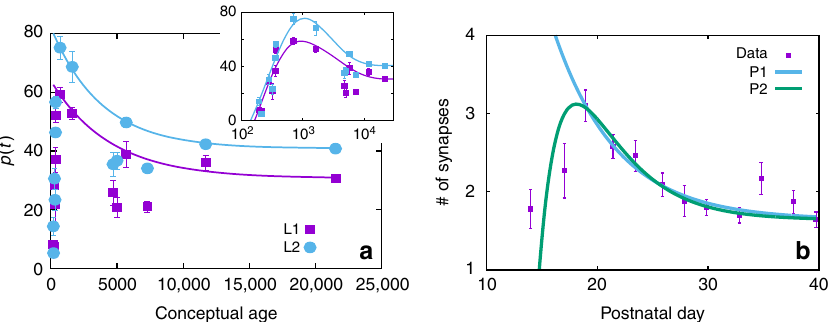
Fig. 2 Synaptic pruning. Experimental data sets on connectivity during infancy (points) and model fi t (solid lines). a Data points correspond to synaptic density, ρ ( t ) ∝ κ ( t ), in the human infant brain, obtained in autopsies by directly counting synapses in tissues from different layers of the auditory cortex (here shown layers 1 (L1) and 2 (L2)) 32 . The solid lines present the best fi t obtained by the model, with τ p , L 1 = 1600(300) and τ p , L 2 = 3800(100). Other parameters are extracted from the data: L1: κ 0 = 59.1, κ ∞ = 30.7 and t 0 = 700; and L2: κ 0 = 75.1, κ ∞ = 40.8 and t 0 = 700, where t 0 is set at the onset of pruning (i.e., corresponding to the maximum of κ ( t )). Inset on the right shows the fi t of the maximum on a log – log scale, labels as in the main plot. Parameters from the fi t are a L 1 = 33(5), τ g , L 1 = 210(20), τ p , L 1 = 3800(200), a L 2 = 1.2(2), τ g , L 2 = 2700(100), τ p , L 2 = 290(40). The three lower points for t ≈ 5000 have been excluded from the fi ts. b Data points correspond to synaptic density measured via large-scale brain imaging experiments that quantify the number of connections in the developing mouse somatosensory cortex 21 . In blue solid lines (P1), fi t with the linear model, for parameters τ p = 5.72(1), κ 0 = 3.10, κ ∞ = 1.64 and t 0 = 18.97. In green solid lines (P2), fi t including the growth factor, with parameters a = 1.7(1), τ g = 4.0(2) and τ p = 2.2(2). The third point form the right has been excluded from the fi ts. Error bars of the data points correspond to s.d. as obtained in the original works